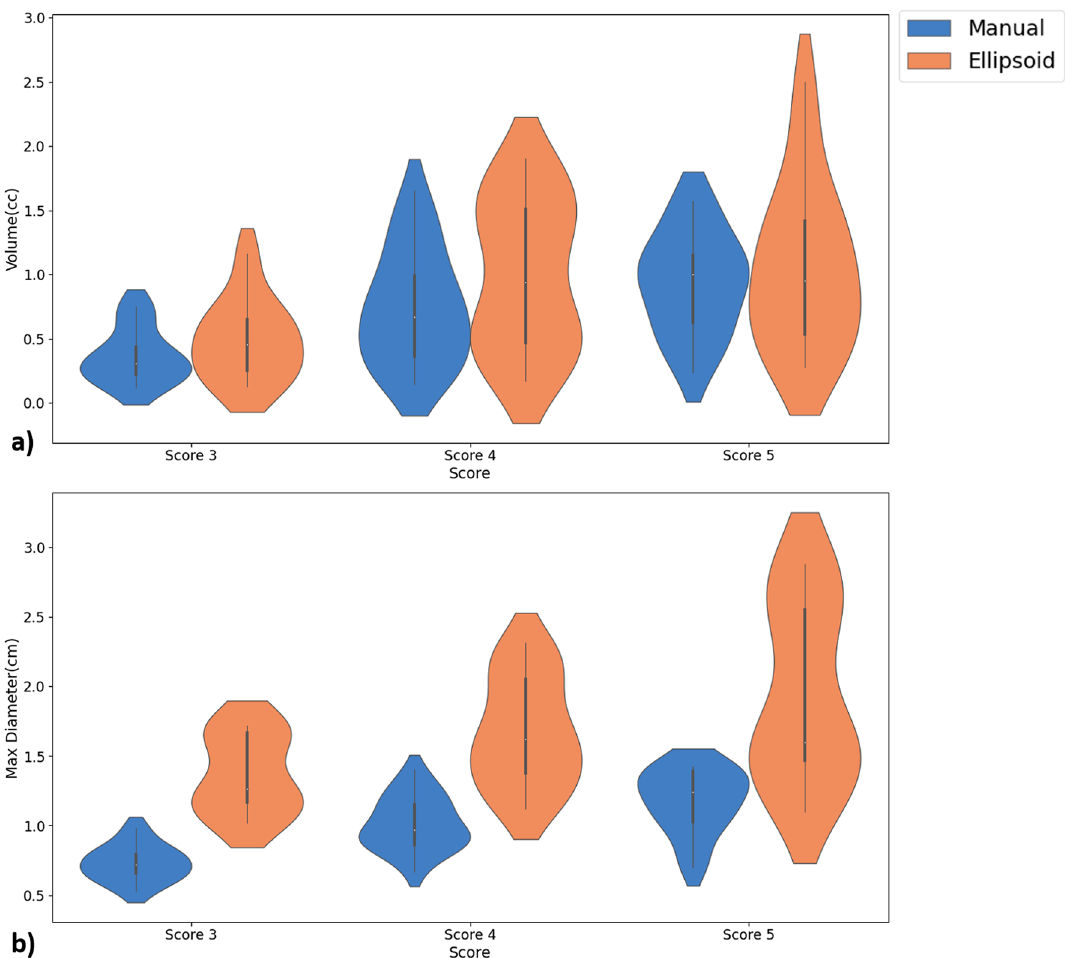
Figure 3. Violin plots for manual assessment and ellipsoid-fit method-based measurements of ( a ) Tumour volume and ( b ) Tumour maximum diameter for scores 3, 4 and